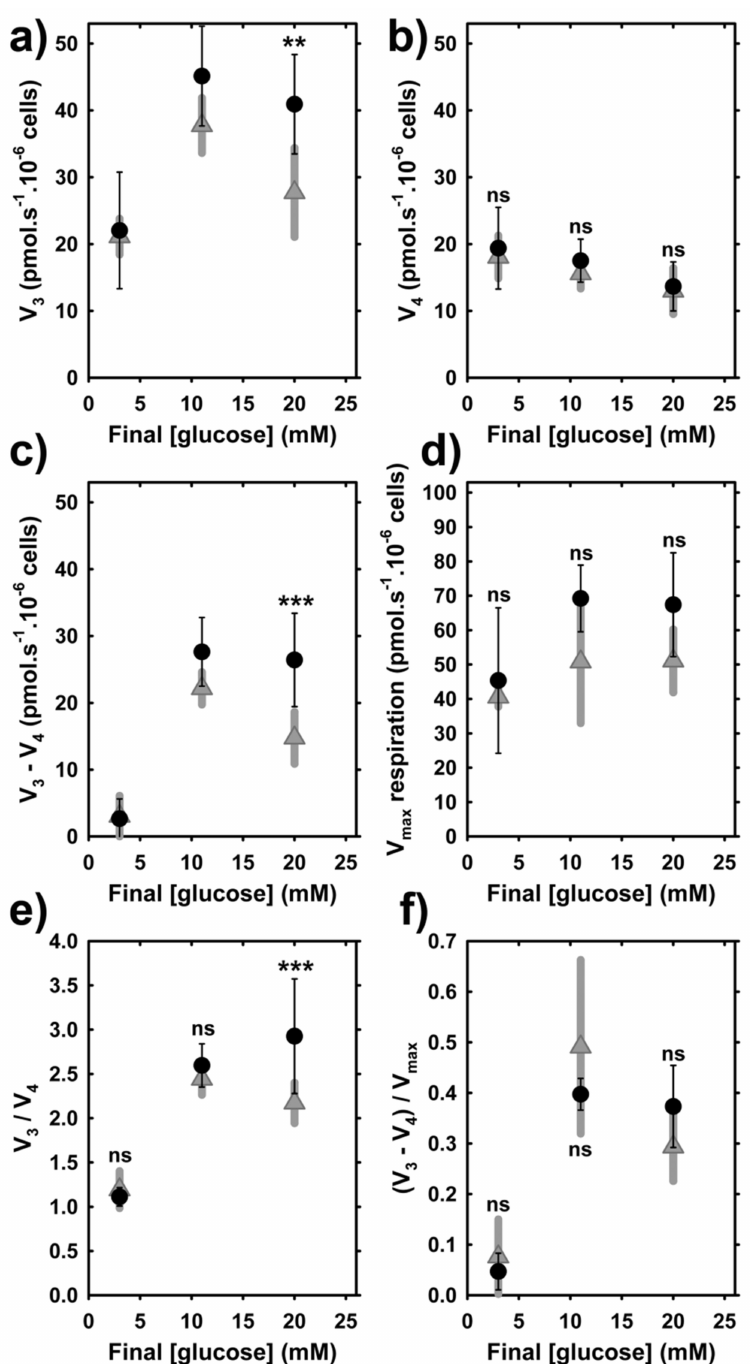
Figure 7. Respiration of control and DAPIT-silenced INS-1E cells. Glucose concentration dependencies for 120 min induction ( N = 4, n = 6–8), after which respiration of was estimated in INS-1E cells transfected with scrambled sequence containing siRNA ( black ) or Dapit / Usmg 5 siRNA ( gray ) (data, SDs) such as: ( a ) phosphorylating (basal) respiration rates ( V 3 ); ( b ) non-phosphorylating respiration rates ( V 4 ); ( c ) ATP synthase-related respiration rates ( V 3 − V 4 ); ( d ) maximum respiration rates V max (derived from titration with an uncoupler FCCP); ( e ) Ratios V 3 / V 4 , i.e., between phosphorylating vs. non-phosphorylating respiration rates; and ( f ) R ATP synthesis , i.e., portion of total respiratory chain capacity required for the ATP synthesis calculated as ( V 3 − V 4 ) / V max . *** p < 0.001, ** p < 0.05 for significant di ff erences of DAPIT-silenced vs. cells transfected with scrambled